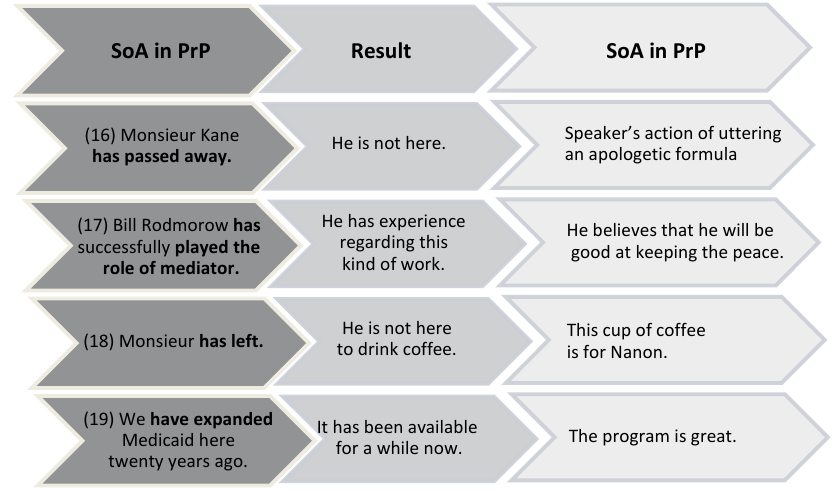
Figure 1. Parallels between examples of different